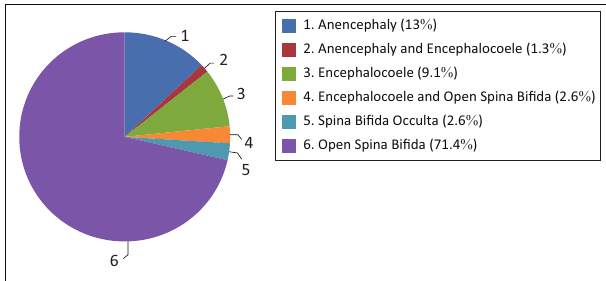
FIGURE 3: Distribution of types of neural tube defects (NTDs).